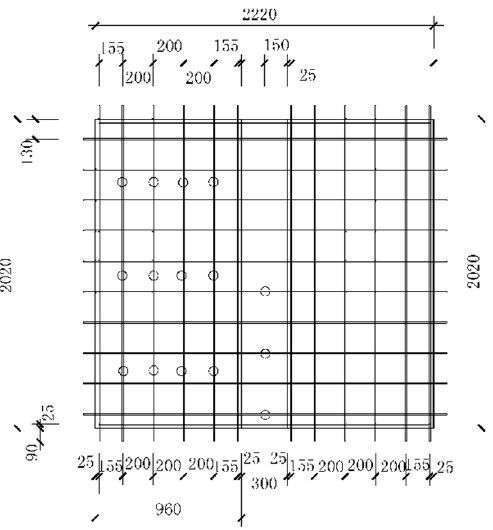
Figure 15. The lay − out diagram of stacked floor tensioned steel strain gauge.